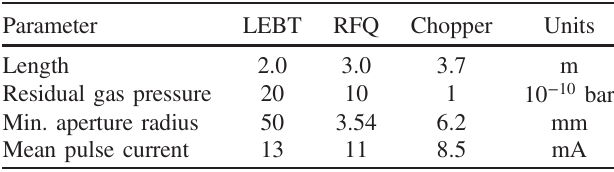
TABLE II. Residual gas background simulation parameters.